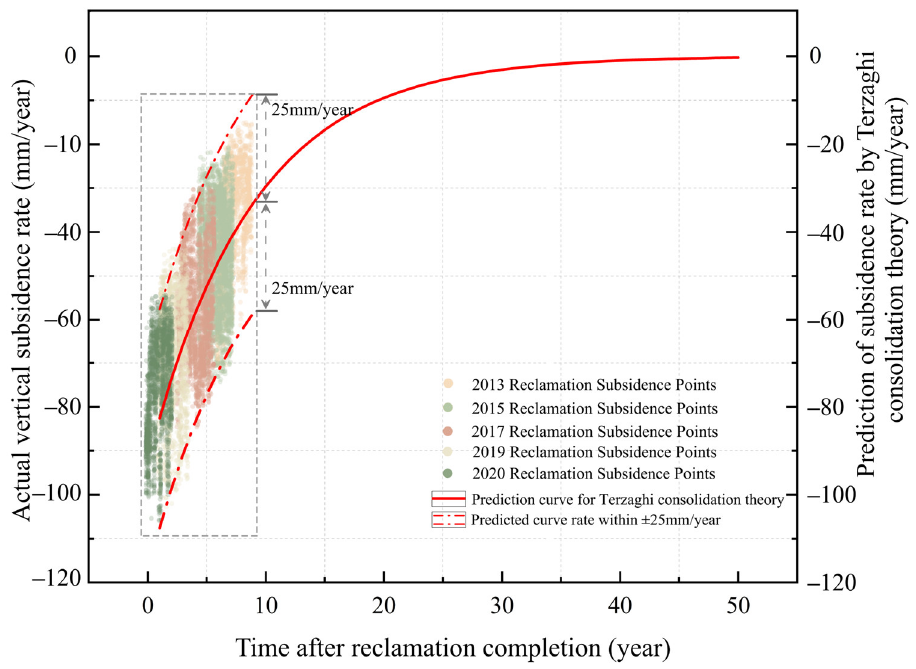
Figure 11. Prediction based on Terzaghi consolidation theory.